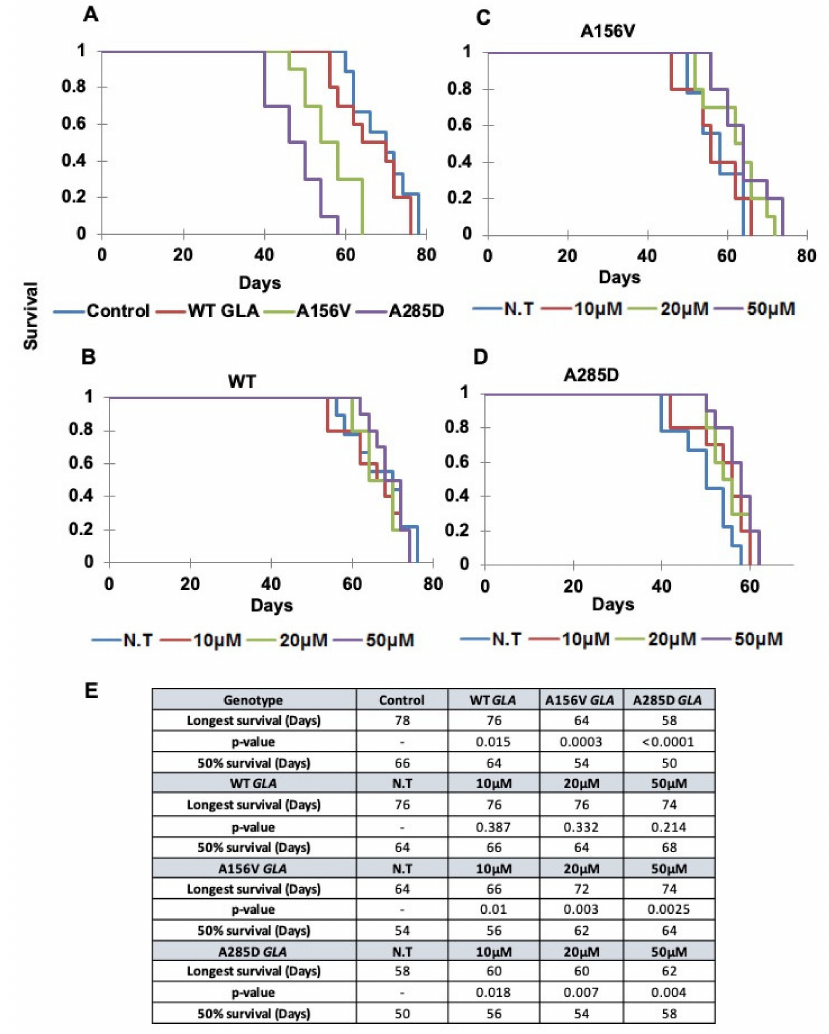
Figure 7. Survival of flies. ( A ) Kaplan–Meier curve showing the overall survival rates of flies expressing di ff erent GLA transgenes compared to normal control (Oregon-R) flies. ( B – D ) Kaplan–Meier curve showing the overall survival rates of flies expressing the di ff erent α -Gal A variants, treated with di ff erent migalastat concentrations. The expression of the α -Gal A mutant variants was under the dopa decarboxylase GAL4 driver (DdcGAL4). N.T.: non-treated. ( E ) A table showing the day reached